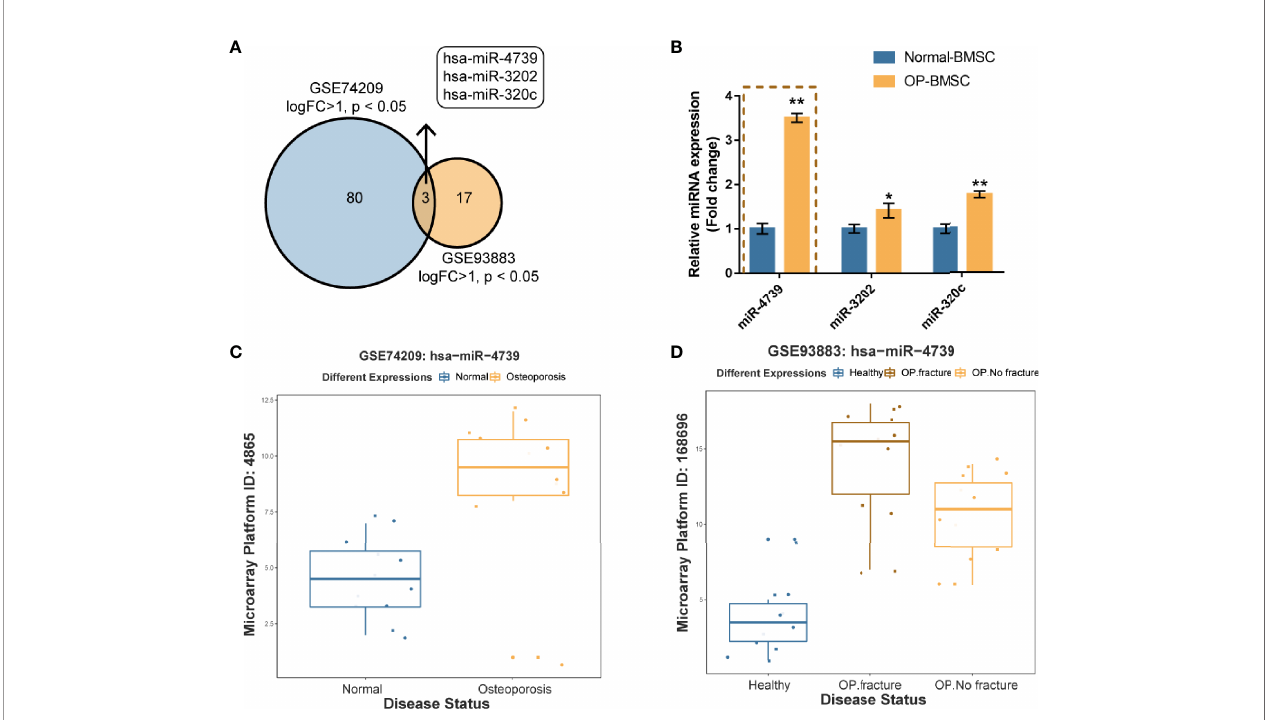
FIGURE 1 | miR-4739 expression is deregulated in osteoporotic bone marrow-derived mesenchymal stem cells (BMSCs) (A) miRNAs differentially expressed in postmenopausal women undergoing hip replacement due to either osteoporotic fracture or osteoarthritis in the absence of osteoporosis (GSE74209) or plasma from non-osteoporotic and osteoporotic patients with and without vertebral fractures (GSE93883) were compared (logFC >1, p < 0.05) and 3 miRNAs (miR-4739, miR- 3202, and miR320c) were overlapped in two datasets. (B) The expression of miR-4739, miR-3202, and miR-320c in normal and osteoporotic BMSCs was determined by RT-PCR. (n=3) (C, D) The expression of miR-4739 is based on GSE74209 and GSE93883. *p < 0.05, **p <